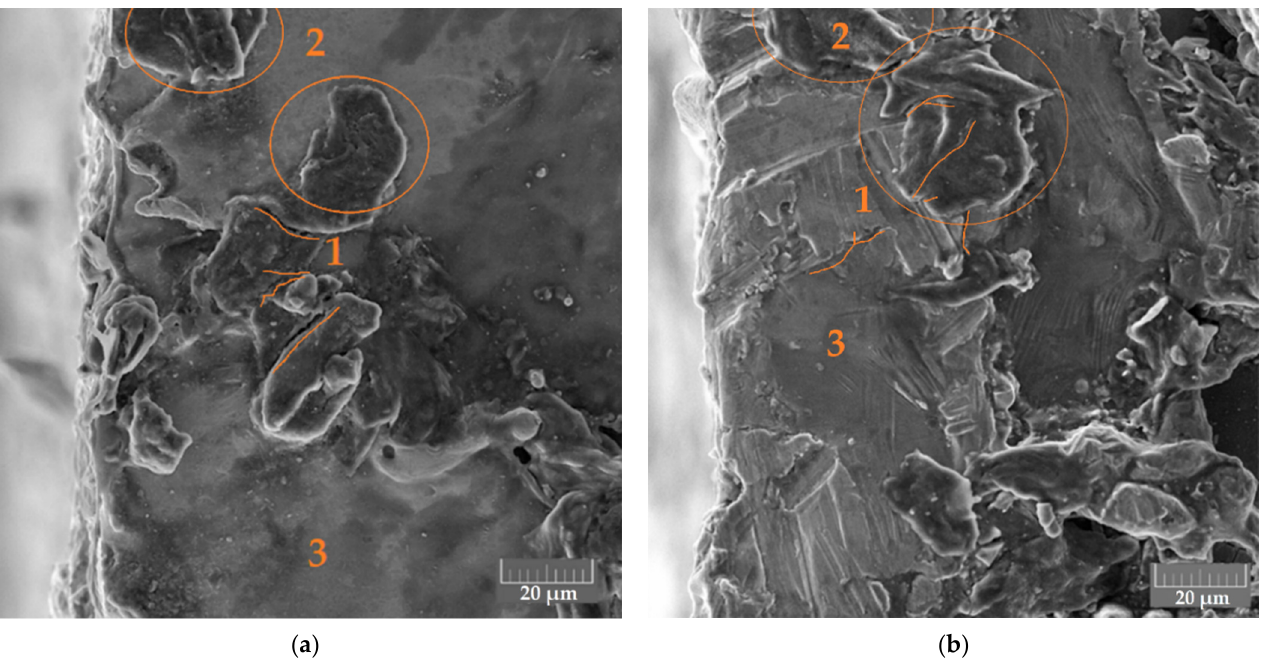
Figure 7. SEM-images of the workpiece surfaces after electrical discharge machining with a brass wire tool electrode in a water medium at the place of wire tool penetration: ( a ) X10CrNiTi18-10 (12kH18N10T) steel; ( b ) 2024 (D16) duralumin, where (1) is thermal cracks, (2) is deposed flakes of metastable solid solutions and/or eutectics, (3) is recast and heat-affected primary material of the workpieces.